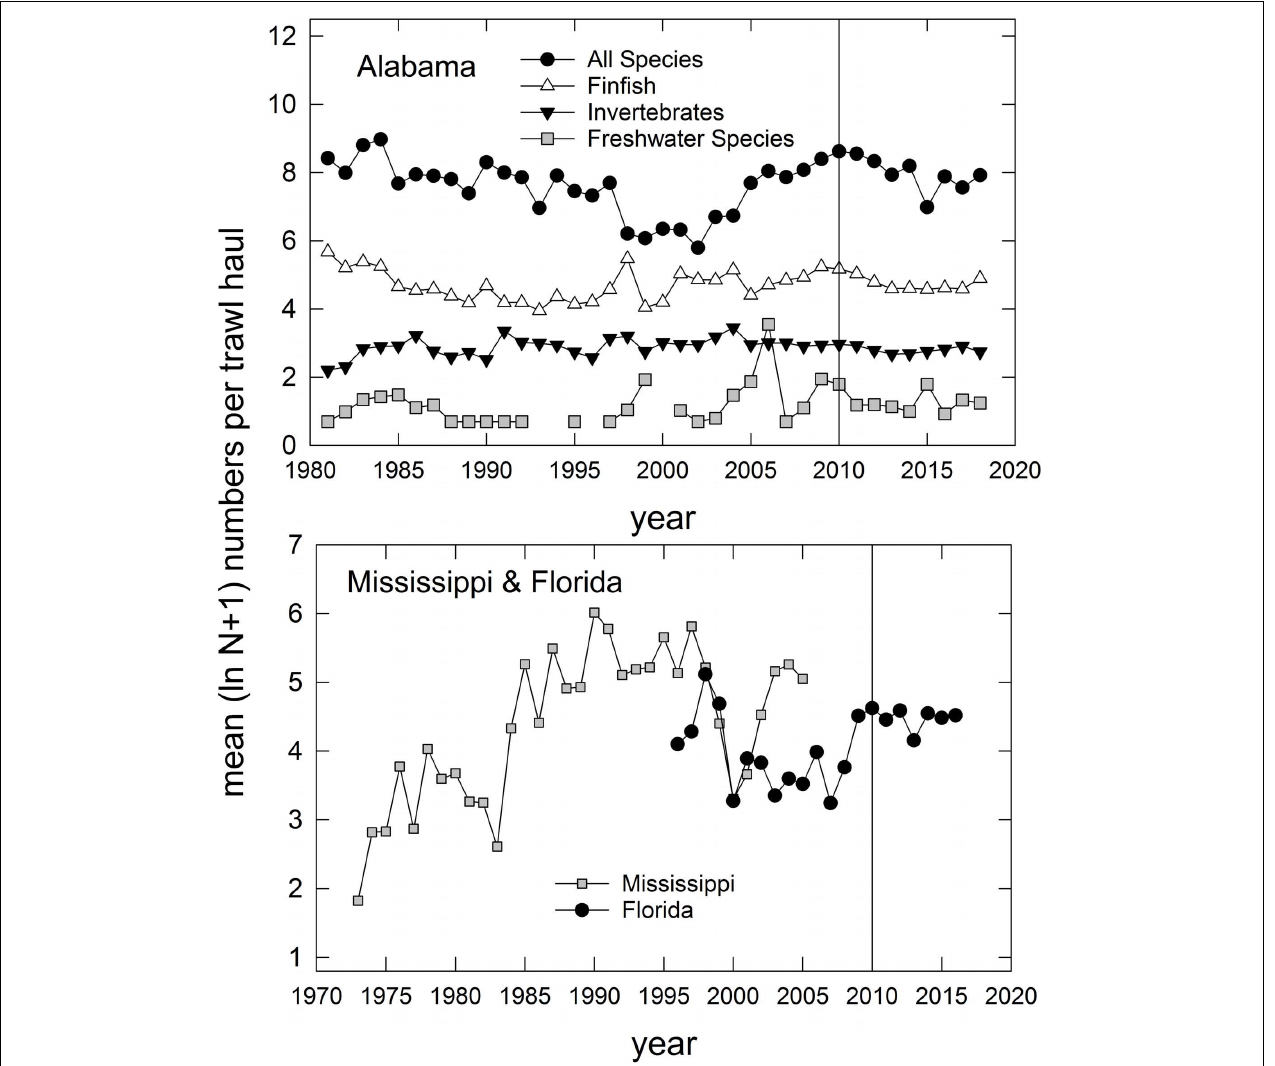
FIGURE 4 | Annual relative abundance (mean ln [N + 1]) of species caught in trawl surveys in Alabama (top panel), Florida (west of 85 ◦ W longitude), and Mississippi (partial time series; bottom panel). Vertical line represents the year that the Deepwater Horizon accident occurred. For Alabama trawl catches, species are divided into several groups, consistent with categories indicated in Supplementary Table 1 . Data are from the Alabama Marine Resources Department, the Louisiana Department of Wildlife and Fisheries, and the Florida Fish and Wildlife Research Institute. Data for Mississippi were collected by Mississippi Department of Marine Resources, and are served via the National Centers for Environmental Information (NCEI) at: https://data.noaa.gov/dataset/dataset/fisheries-independent-